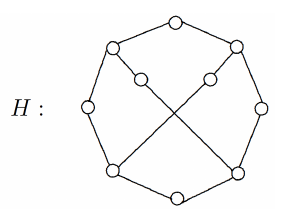
Figure 4: A graph H for which K 4 , 6 is H